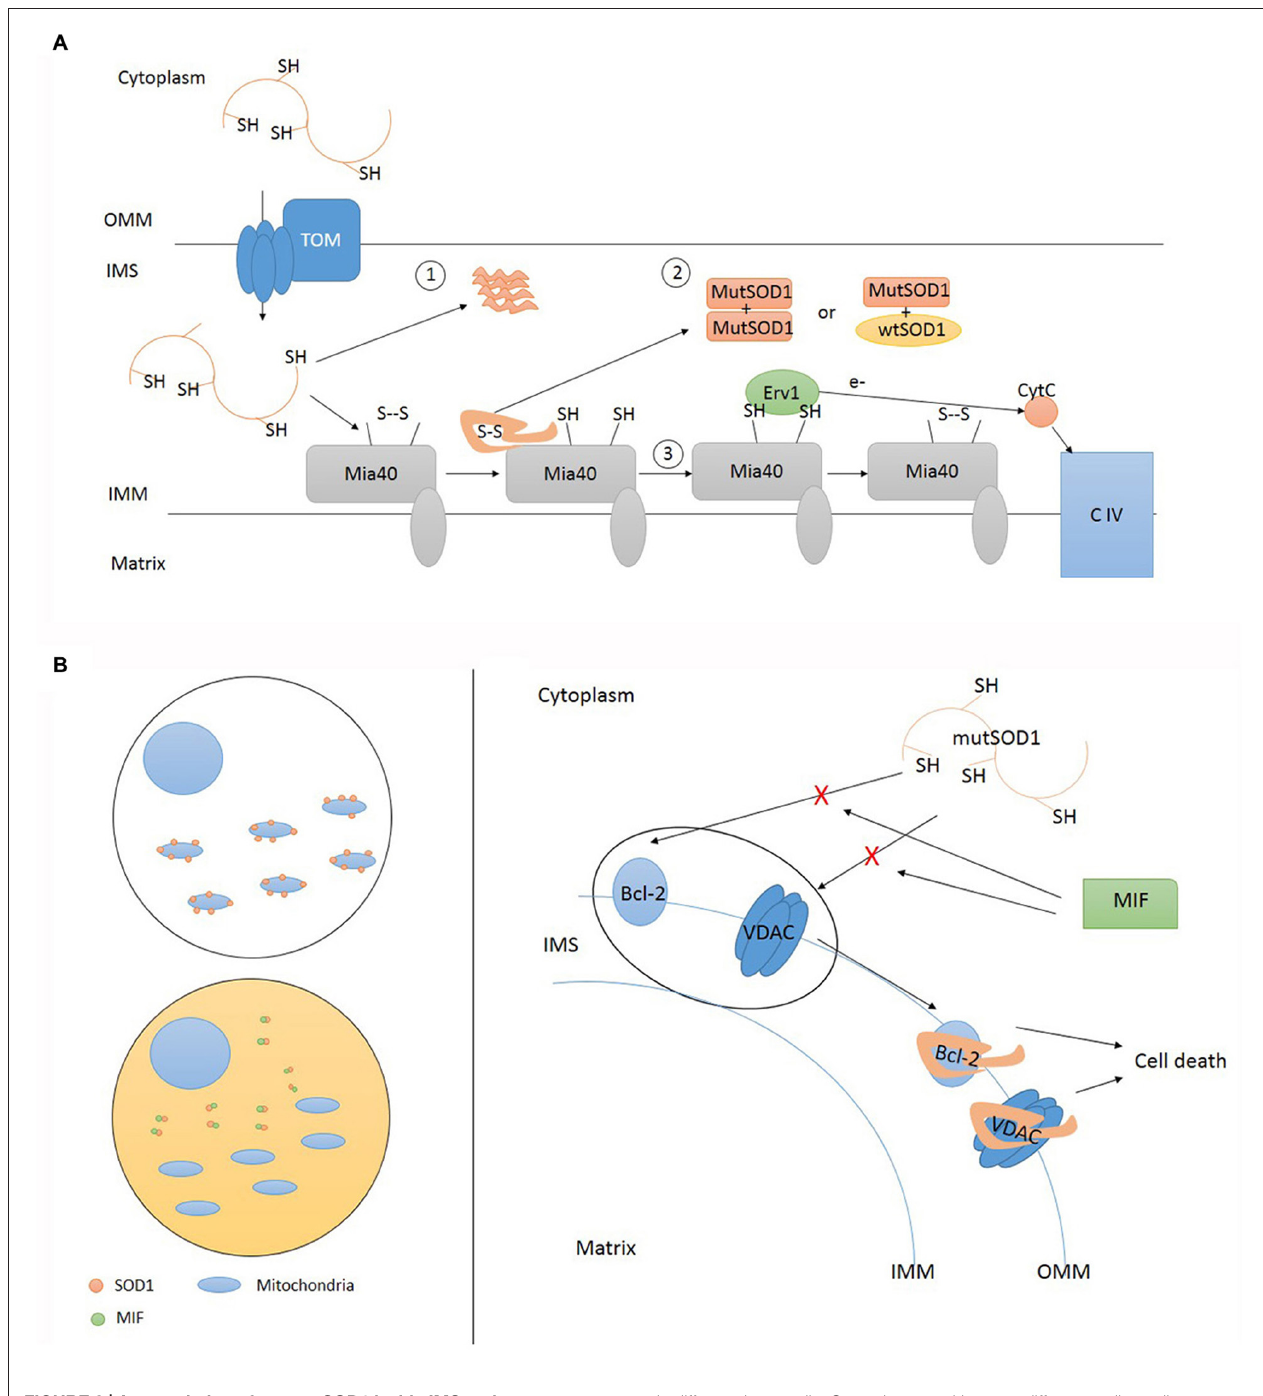
FIGURE 3 | Accumulation of mutant SOD1 inside IMS and deposition onto OMM. (A) Mutant SOD1 enters IMS through TOM. Inside IMS mutant SOD1 can precipitate in insoluble form (1) or undergo folding via Mia40 resulting in the establishment of funtional homodimers and heterodimers (2). Mia40 transfers electrons to Cytochrome C (CytC) via Erv1 (3). TOM, translocase of outer membrane; OMM, outer mitochondrial membrane; IMS, intermembrane space; IMM, inner mitochondrial membrane; CIV, complex IV cytochrome C oxidase; MutSOD1, mutant SOD1. (B) Misfolded SOD1 localization upon mitochondria can be regulated